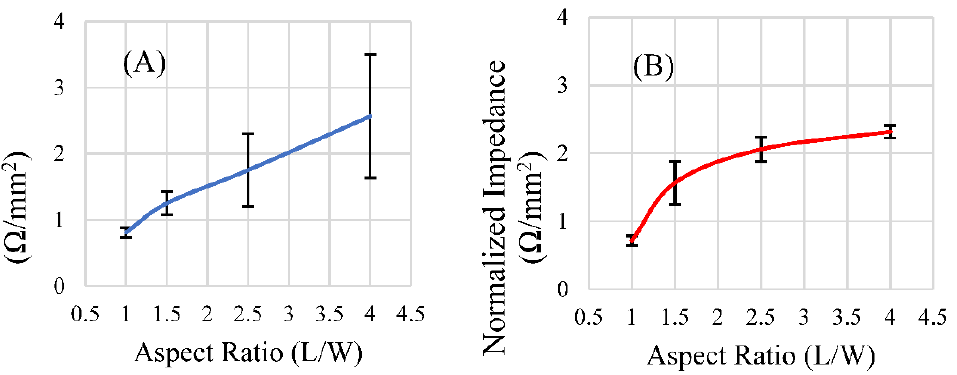
Figure 12. The response of rectangular sensors fabricated at lengths 9 mm ( A ) and 12.7 mm ( B ), normalized for their surface area, plotted against the aspect ratio of those sensors ( n = 4, error = ± standard deviation).